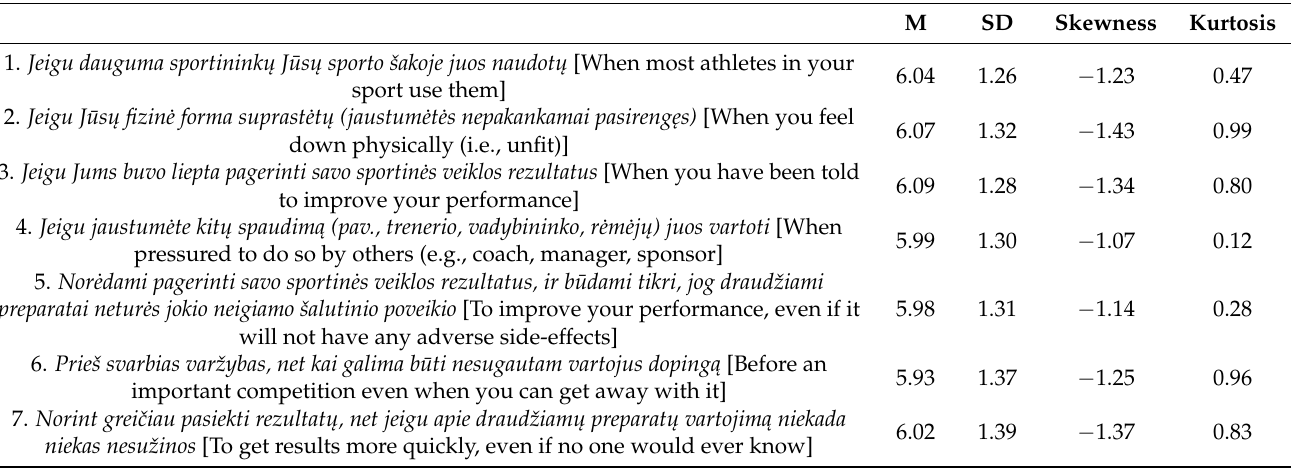
Table 1. Descriptive and item analyses of Lithuanian version of the sport-specific doping self- regulatory efficacy scale.